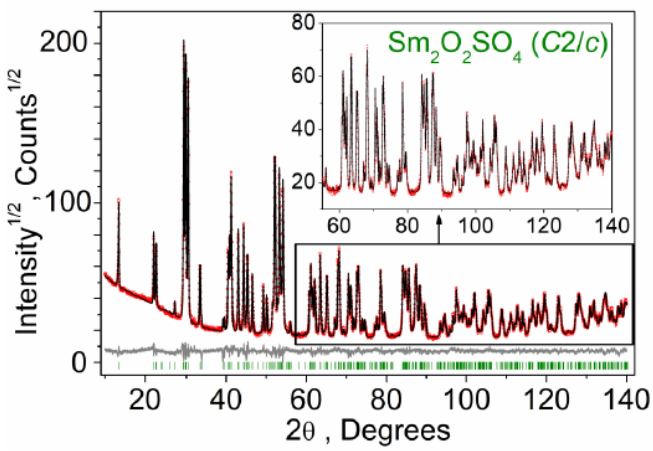
ff erence Rietveld plot of Sm Figure 5. Difference Rietveld plot of Sm 2 O 2 SO 4 . Figure 5. Di